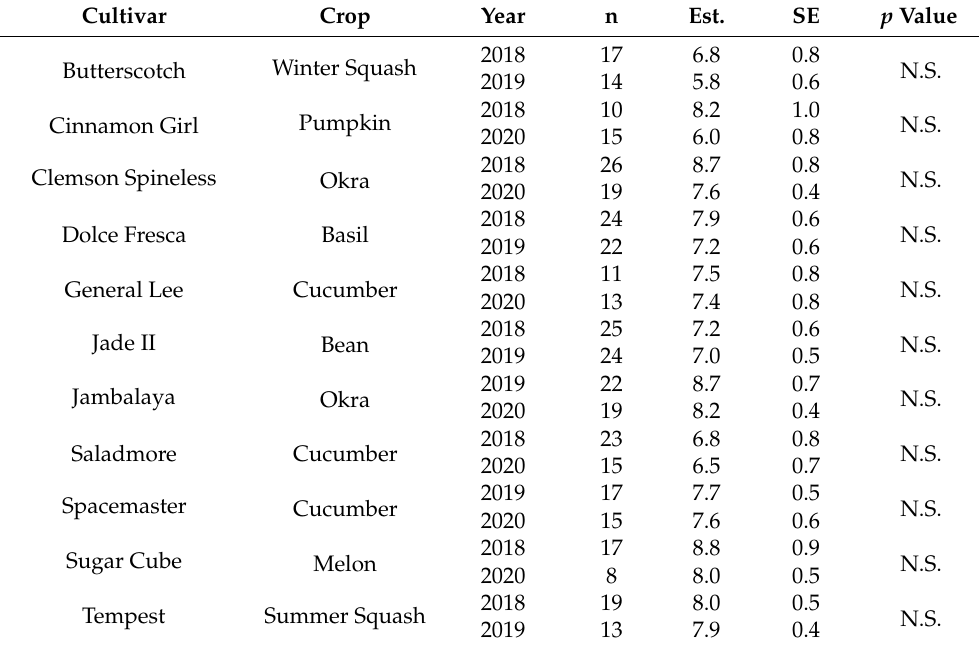
Table 10. Mean performance rating by year within cultivars evaluated over multiple years (2018–2020 trials). Performance was rated on a scale of 1 to 10, with 1 indicating poor performance and 10 indicating excellent performance. The number of participants who returned usable data for each cultivar is reported as “n”. Mean separation was performed using Fisher’s Protected LSD with an alpha level of p < 0.1. Crop Year n Est. SE p Value